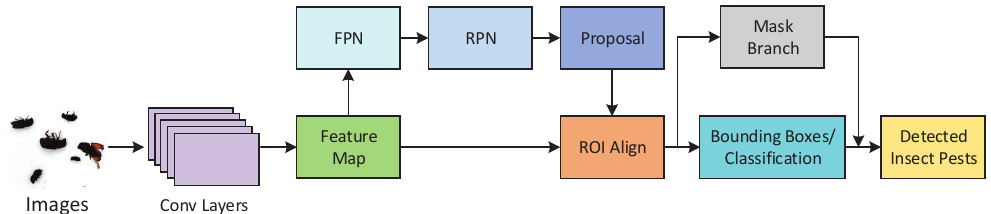
Figure 11. Mask-RCNN ResNet50